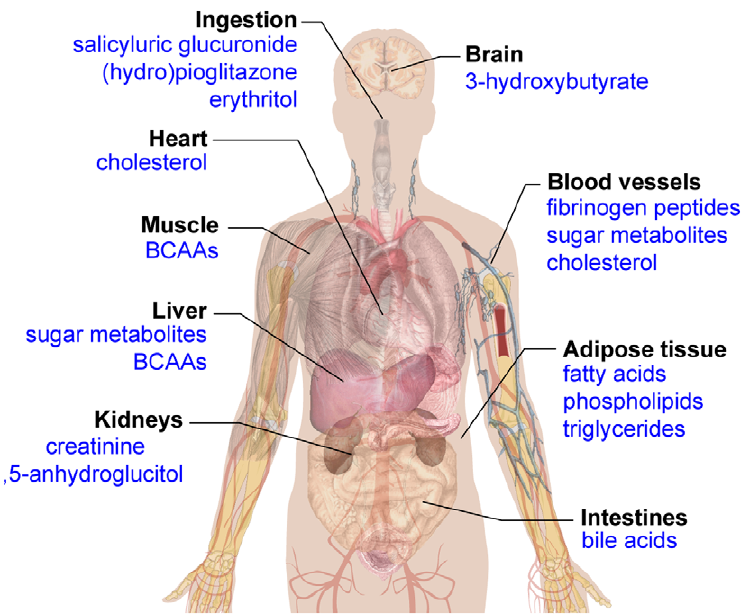
Figure 3. A systemic view of metabolic markers that associate with diabetes in this study. The coverage of the metabolome’s diversity allows the detection of systemic metabolic imbalances, thereby providing a disease specific picture of human physiology.